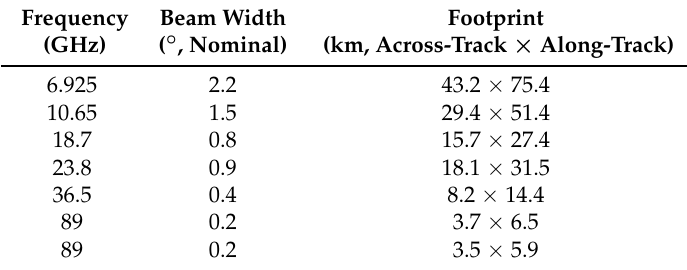
Table 1. Nominal footprint size (reproduced from ([11], pp.